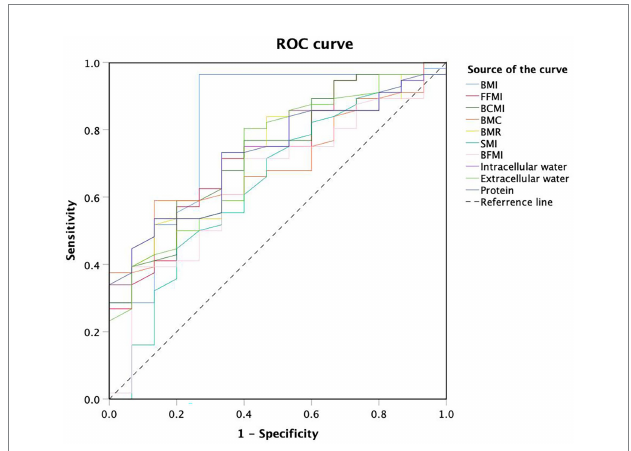
FIGURE 3 Receiver operating characteristic curve analysis of body composition cut-off values for malnutrition.